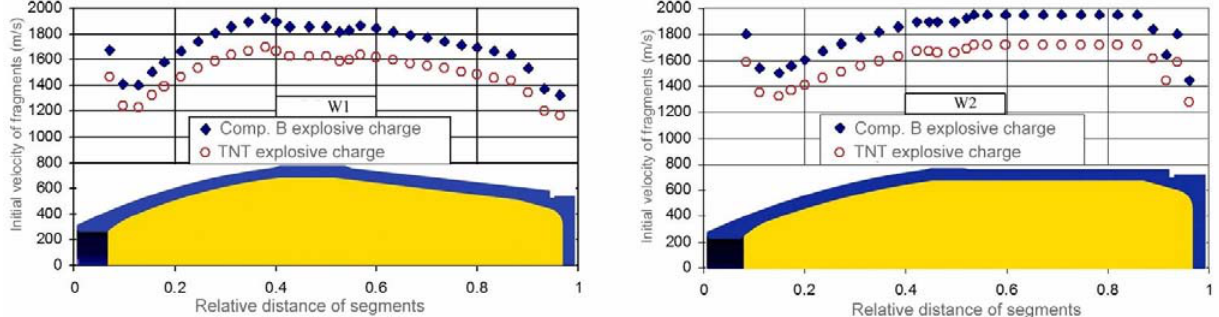
Figure 6. Variation of initial velocity of fragments, depending on the type of explosives (TNT and Composition B) for mortar HE projectiles 120mm (warheads W1 and W2) [19]